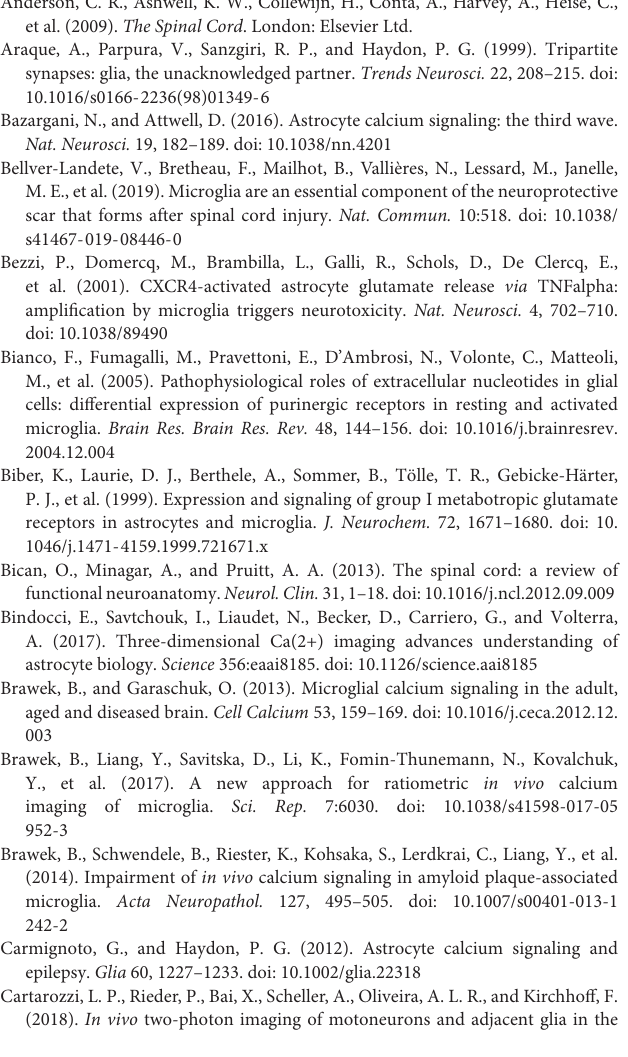
bins), (B) signal duration, divided 2 s bins) and (C) ROA area (divided into 5 µ m 2 bins) for astroglia (blue) and microglia (yellow) in gm (solid) and wm (dashed) of acute slice preparations. Data with peak amplitudes greater than 0.7 (cid:49) F/F 0 (0.7 ± 0.5%), durations longer than 40 s (0.1 ± 0.1%) and ROA area greater than 120 µ m 2 (0.6 ± 0.2%) were excluded from the representation for easier display. Data were represented as mean ± SEM, fitted with a lognormal curve using a Least-Squares fitting with no weighting method and compared using the extra-sum-of-squares F test. F ratios and relative p-values of single curve comparisons were schematically represented as a squared diagram and gray-scaled color-coded. Smaller insets represent magnified views of the fitting curves. N (animals) = 4 (astroglia), 5 (microglia, gm ), 6 (microglia, wm ). n (FOVs) = 12 (astroglia, gm ), 14 (astroglia, wm ), 15 (microglia, gm ), 22 (microglia, wm ). ∗∗∗∗ p < 0.0001. Supplementary Figure 3 | In vivo distribution of glial signal amplitudes, durations and ROA areas. (A) Relative frequency of signal amplitude (divided into 0.15 (cid:49) F/F 0 bins), (B) signal duration (divided into 2 s bins) and (C) ROA area (divided into 25 µ m 2 bins) for astroglia (blue) and microglia (yellow) in vivo ( d1 , d2 and d7 , wm ) and ex vivo ( d0 , wm ). Data with peak amplitude greater than 0.5 (cid:49) F/F 0 (3.3 ± 1.3%), duration longer than 40 s (0.4 ± 0.3%) and ROA areas larger than